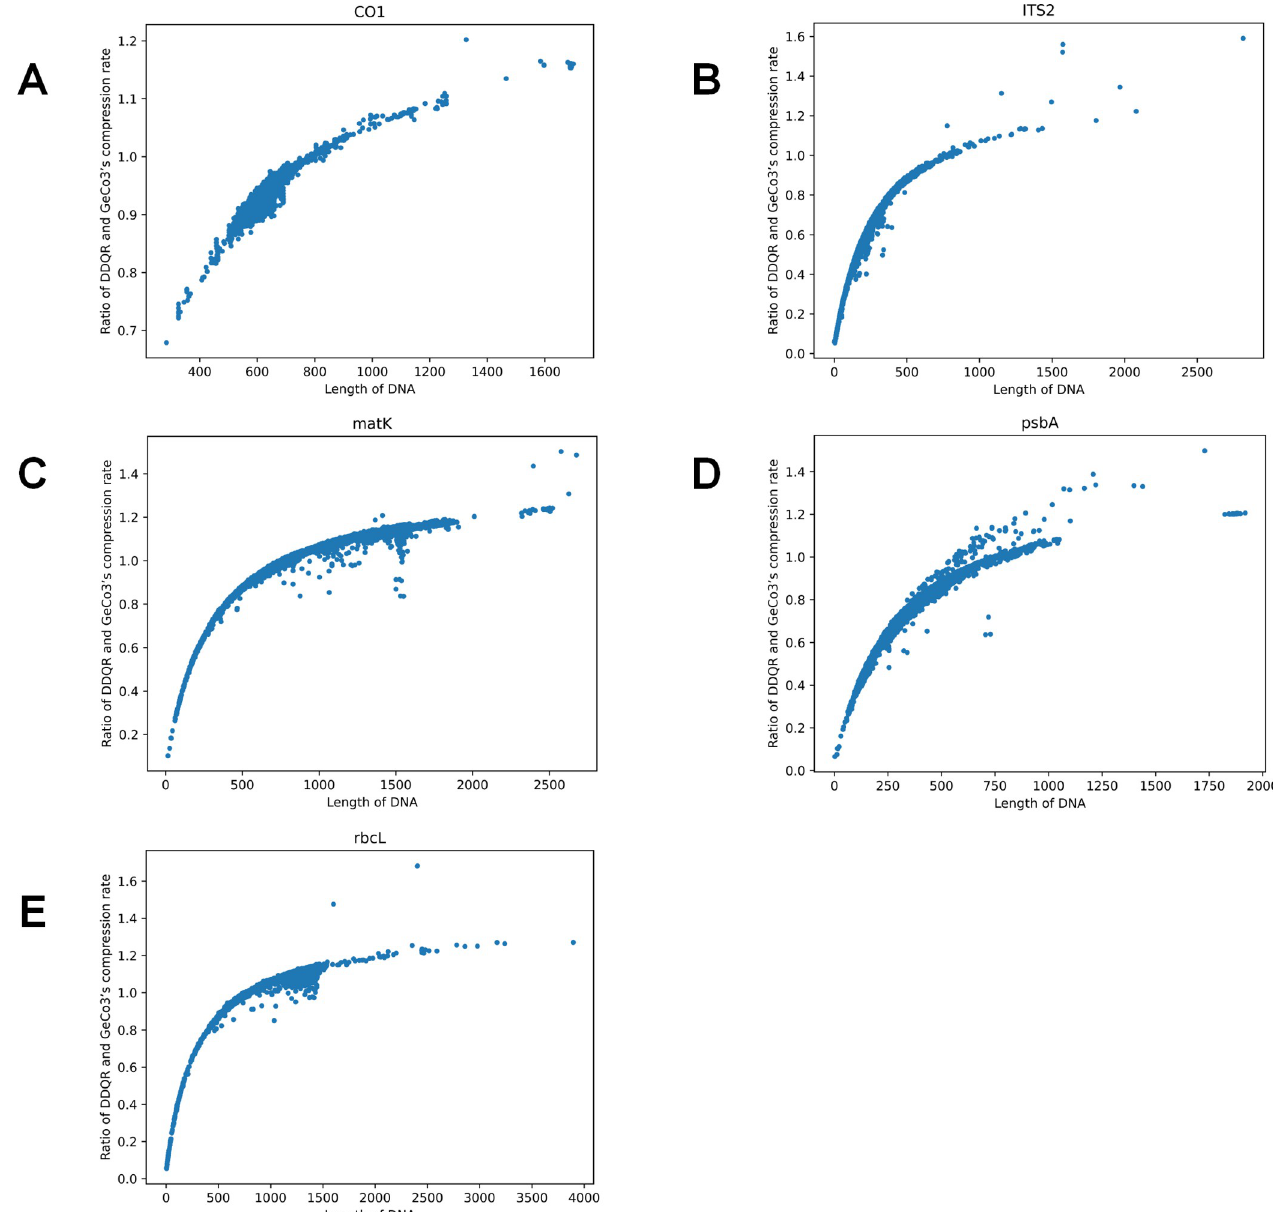
Fig 5. Comparison of compression rates of DDQR and Geco3 using real data. Five different DNA barcode marker datasets are used: ITS2 (A), rbcL(B), matK (C), psbA-trnH (D), and CO1 (E). The X-axis is the compression rate. The Y-axis is the frequency of the corresponding ratio of DDQR and GeCo3’s compression